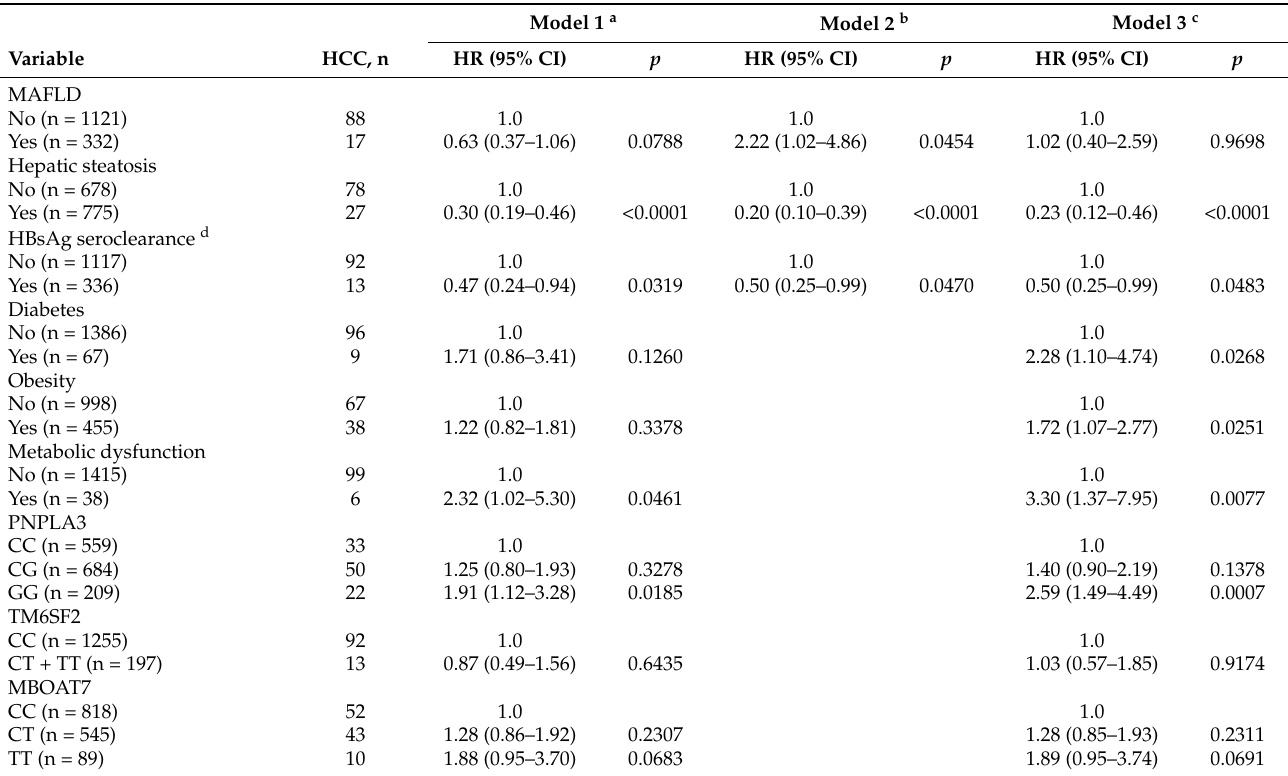
Table 2. Adjusted hazard ratios of risk factors for incident hepatocellular carcinoma. Model 1 a